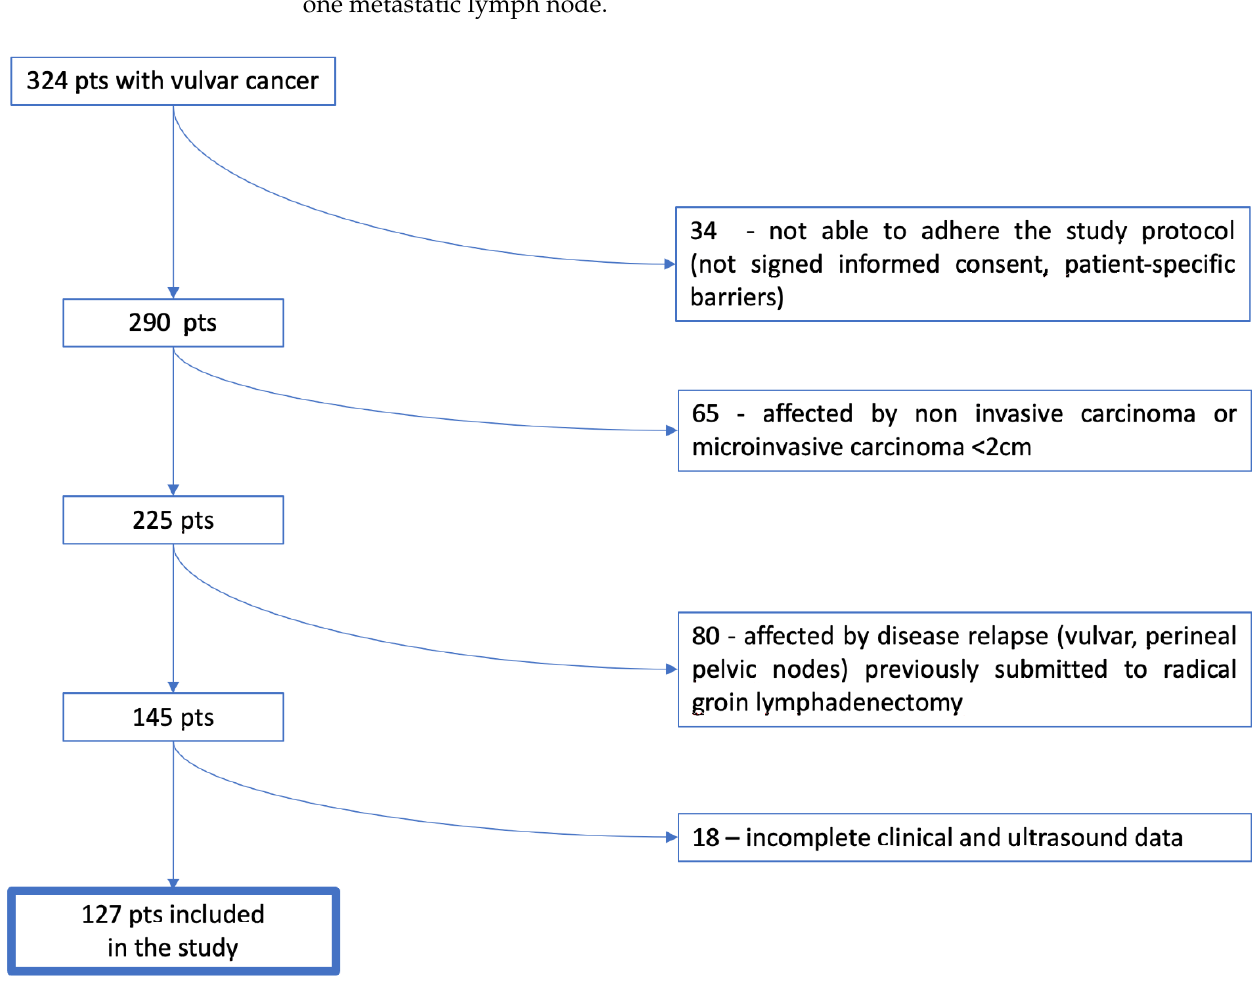
Table 1. Clinical, surgical, histopathologic and ultrasound features.